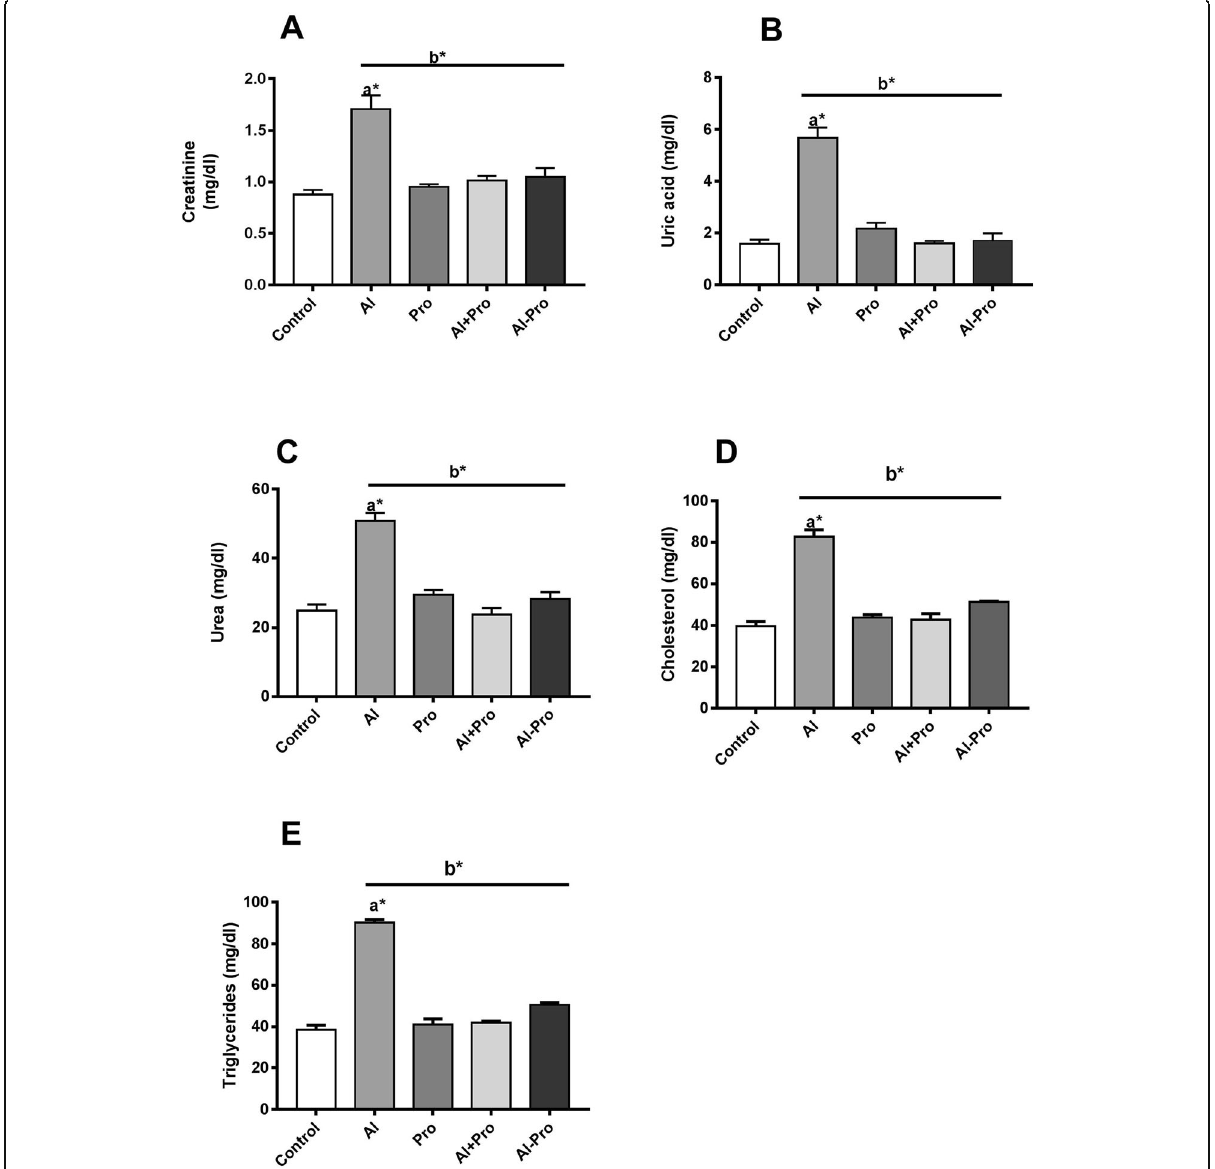
Fig. 1 Effect of propolis for two months on the plasma level of alanine aminotransferase (ALT) ( A ), aspartate aminotransferase (AST) ( B ), plasma alkaline phosphatase (ALP) ( C ), acid phosphatase (AP) ( D ), and lactate dehydrogenase (LDH) ( E ) of rats treated with AlCl3. Significance (a): relative to the control group. Significance (b): relative to the AlC13 group. Significance: P < 0.05, highly significance (*): P <